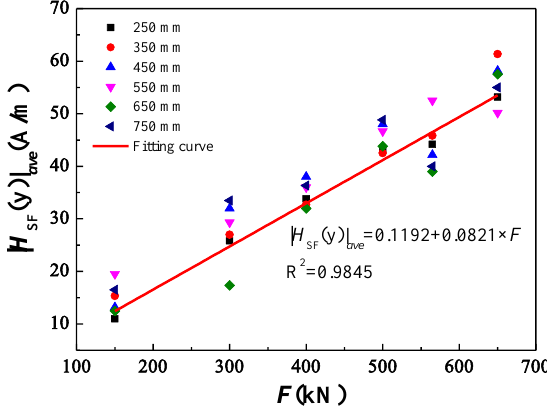
Figure 18. |𝐻 SF (y)| 𝑎𝑣𝑒 - F fitting curves. Figure 18. | H